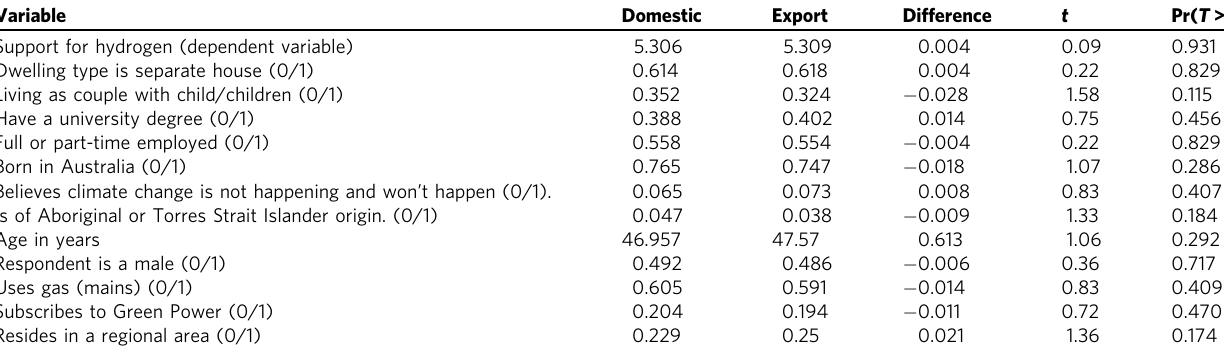
Table 2 Balance test of variables between Domestic and Export streams at the baseline. Variable